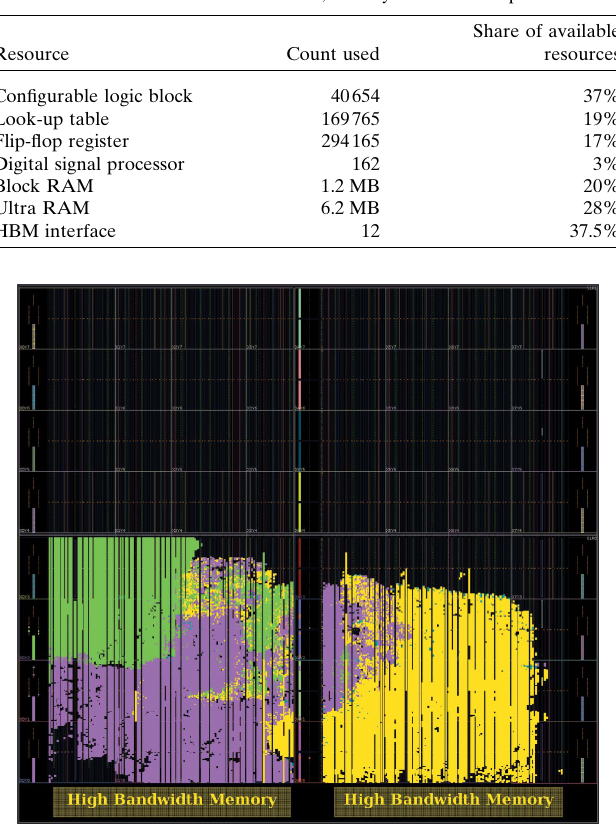
Figure 4 This figure shows how functionalities of Jungfraujoch are placed on the XCVU35P device by the FPGA synthesis tool: network stack (green), host-memory interface including OpenCAPI (purple) and JUNGFRAU specific conversion routines (yellow). The black region, mostly in the top half of the FPGA, is not occupied, leaving space for further functionality. The figure is produced by Xilinx Vivado 2022.1 after an implementation run.